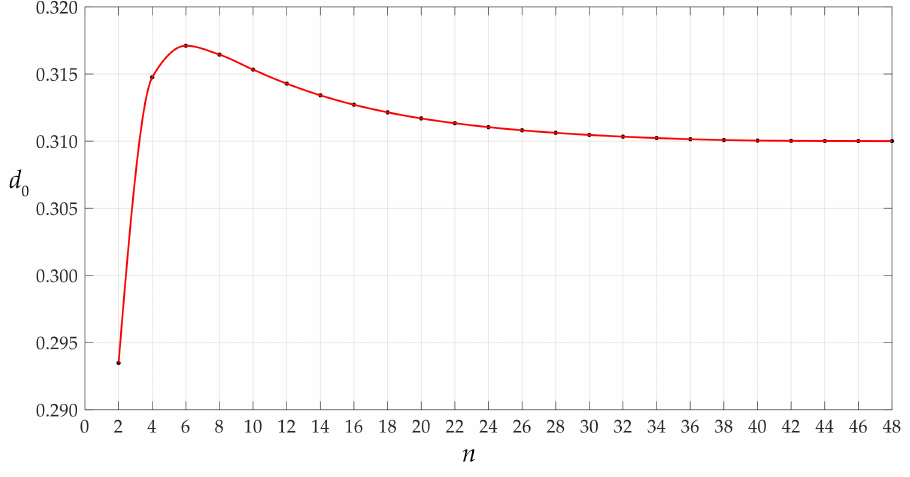
Figure 4. Variations of d 0 with n when q takes 0.003